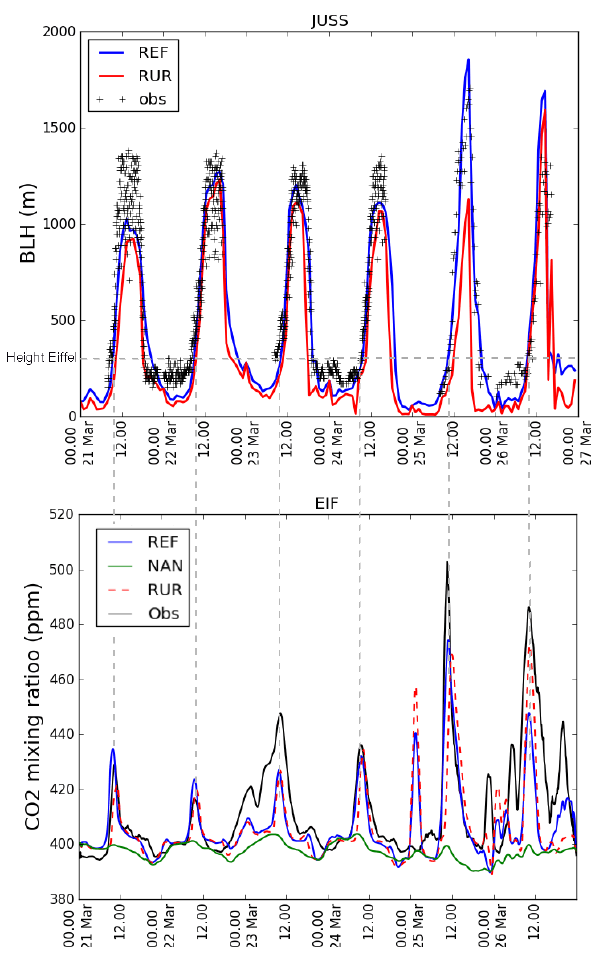
Fig. 11. (a) Time series of BLH predictions and observations at JUSS (in m a.g.l., AGL) for REF (blue) and RUR (red) simulations. (b) Time series of CO 2 observations and predictions (in ppm) at EIF for REF (blue), RUR (red) and NAN (green) simulations, hourly averaged. The vertical dashed lines correspond to the time in the morning at which observed BLHs reach 310 m (Eiffel measurement height).